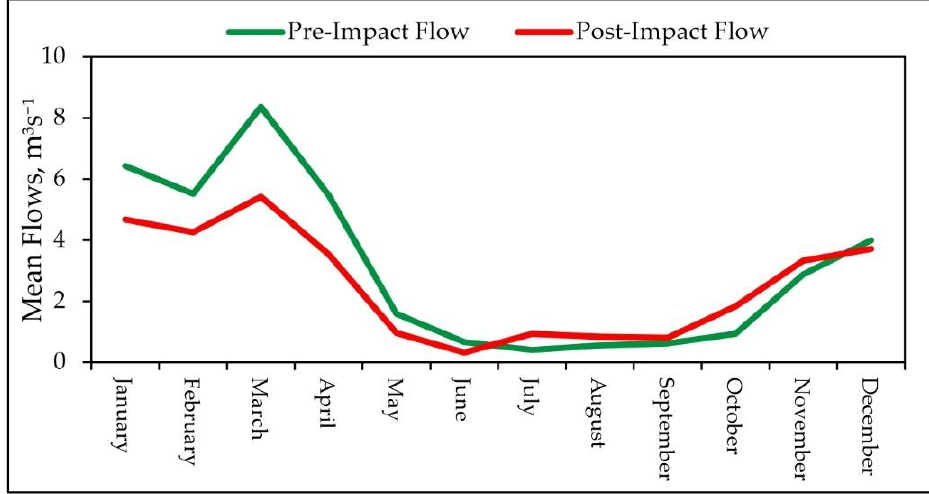
Figure 2. Monthly flow changes (in m 3 s − 1 ) at Mituva-Žindaičiai WGS downstream of Girdžiai HPP.